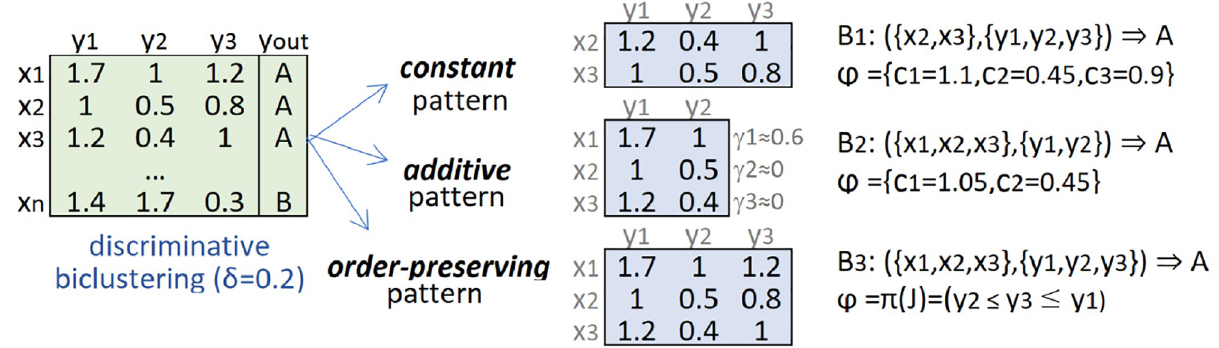
Fig 1. Example of class-conditional subspaces with varying homogeneity. The constant (on columns) subspace has pattern (value expectations) φ { μ 1 = 1.1, μ 2 = 0.45, μ 3 =0.9}, the additive pattern φ y 2 � y 3 � y 1 permutation on 3